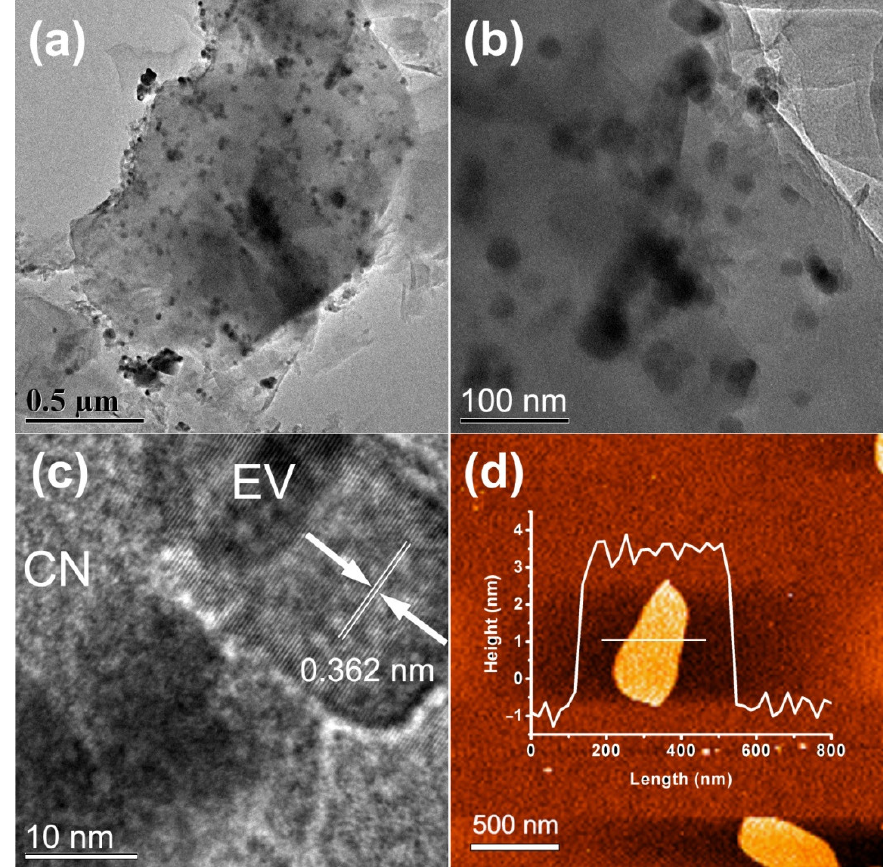
Figure 1. ( a ), ( b ) TEM, ( c ) HRTEM, and ( d ) AFM images of